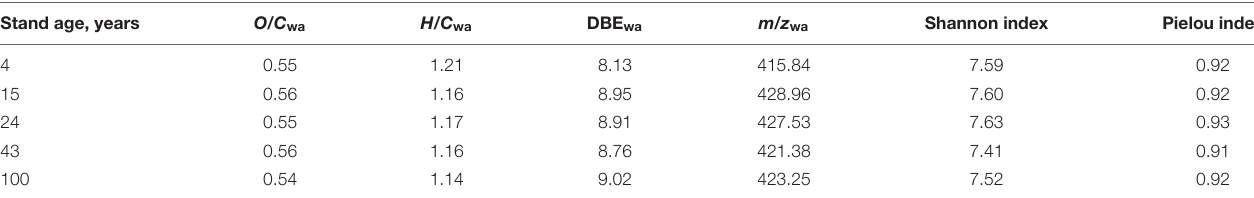
TABLE 1 | Intensity-weighted average (wa) values and chemodiversity indexes for the molecular composition of soil DOM under different stand ages of Chinese fir plantations. Stand age, years O / C wa H / C wa DBE wa m / z wa Shannon index Pielou